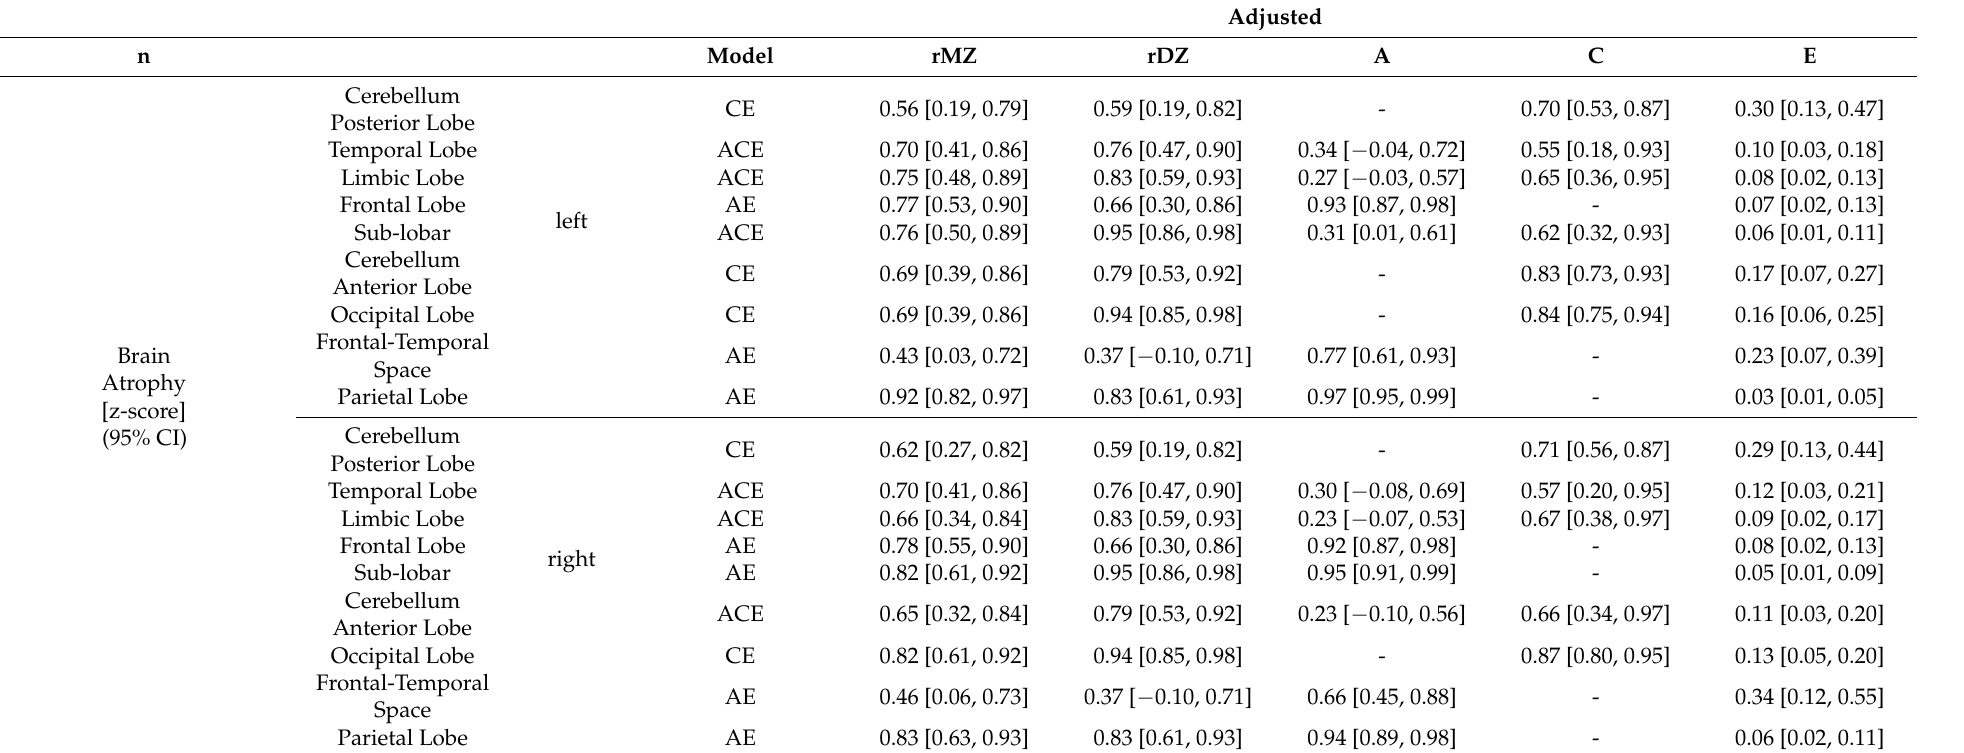
Table 2b. Univariate ADCE model fitting of brain atrophy of the adjusted